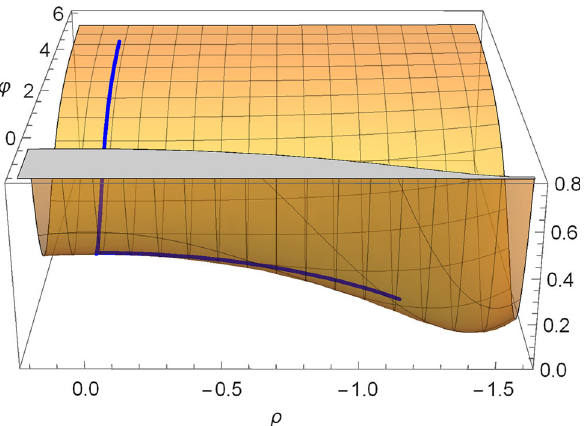
Fig. 2 The inflationary trajectory superimposed on the scalar potential (14)withtheparameters b = − f = 1and c = 10 − 4 .Thelast55e-folds are shown in blue